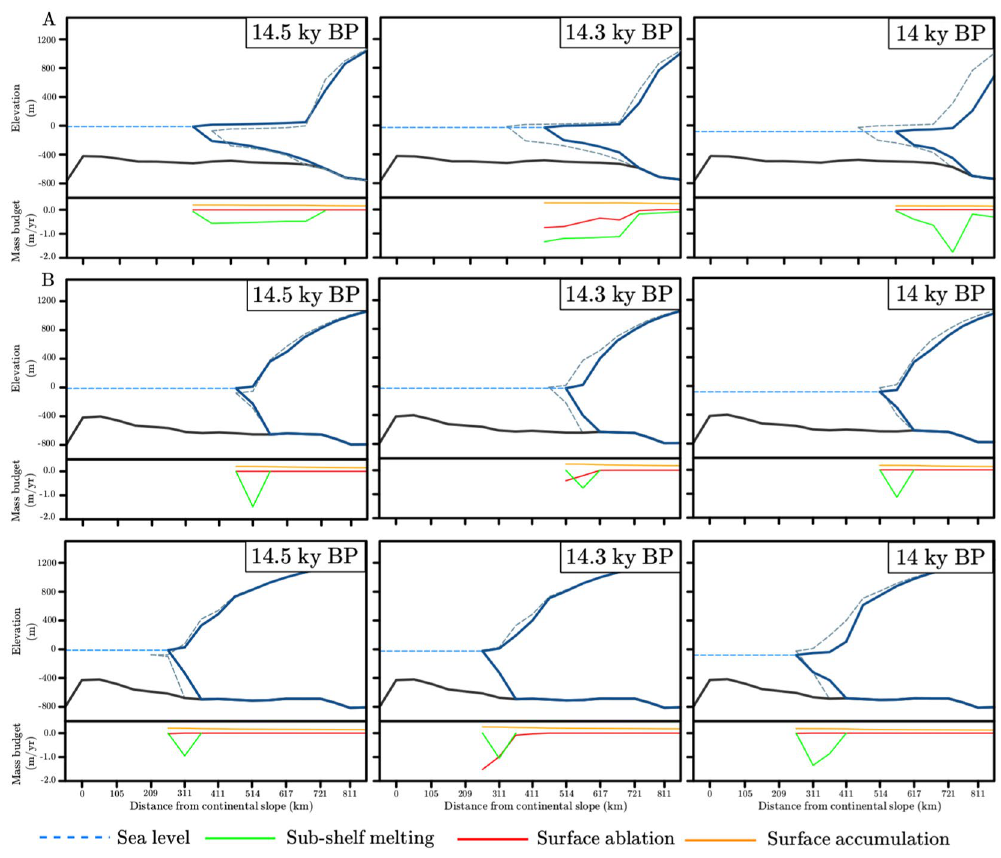
Figure 5. Profile of the Bjørnøyrenna Ice Stream along the cross section AB shown in Fig. 1 at 14.5, 14.3 and 14 ky BP (left, centre and right panel) respectively for ( A ) GBvol, ( B ) PBvol, ( C ) PBvolNS simulations. Continuous blue lines indicate the ice sheet elevation, whereas the continuous black and dashed light blue lines show the bedrock elevation and the regional sea level, respectively. The dashed grey lines indicate the ice sheet elevation at the previous time step to highlight the retreat scenario. Below each ice sheet profile, the mass budget (in meters per year) at each corresponding time frame is plotted: sub-shelf melting (green), surface ablation (red) and surface accumulation (orange) are